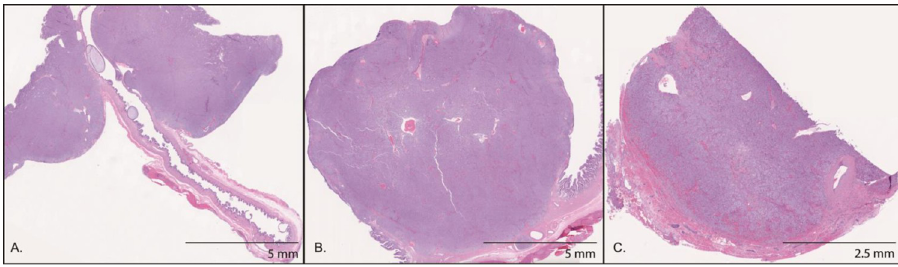
Fig 1. Neuroendocrine neoplasm sections submitted for quantitative proteomics. H&E stained histologic sections of the 2 gallbladder neuroendocrine neoplasms (left panel, middle panel) and the hepatic neuroendocrine neoplasm (right panel). Scrolls of these sections were submitted for proteomic analysis.